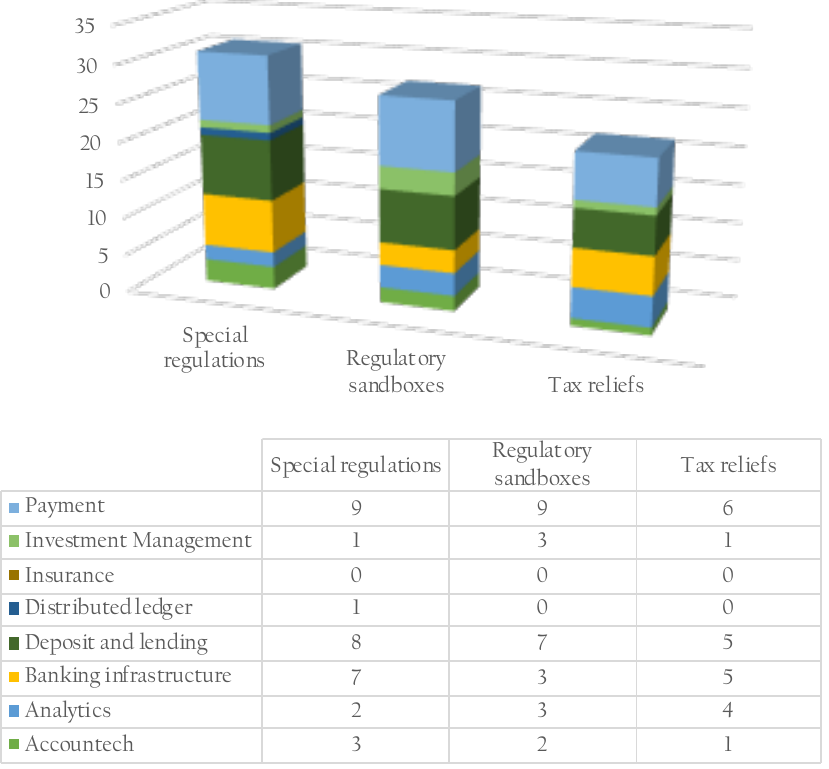
Figure 12. Expected government support—by